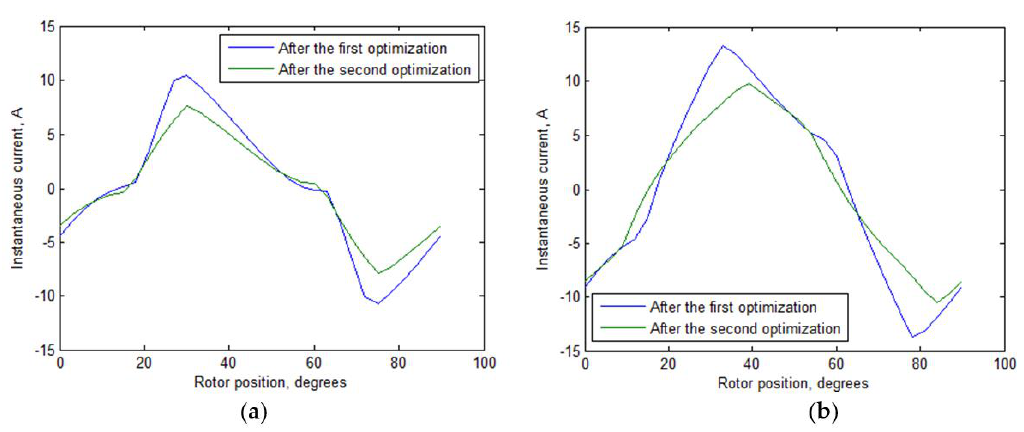
Figure 15. Torque dependencies on the rotor position before and after the second optimization: ( a ) mode 1; ( b ) mode 2. ( a ) mode 1; ( b ) mode 2.